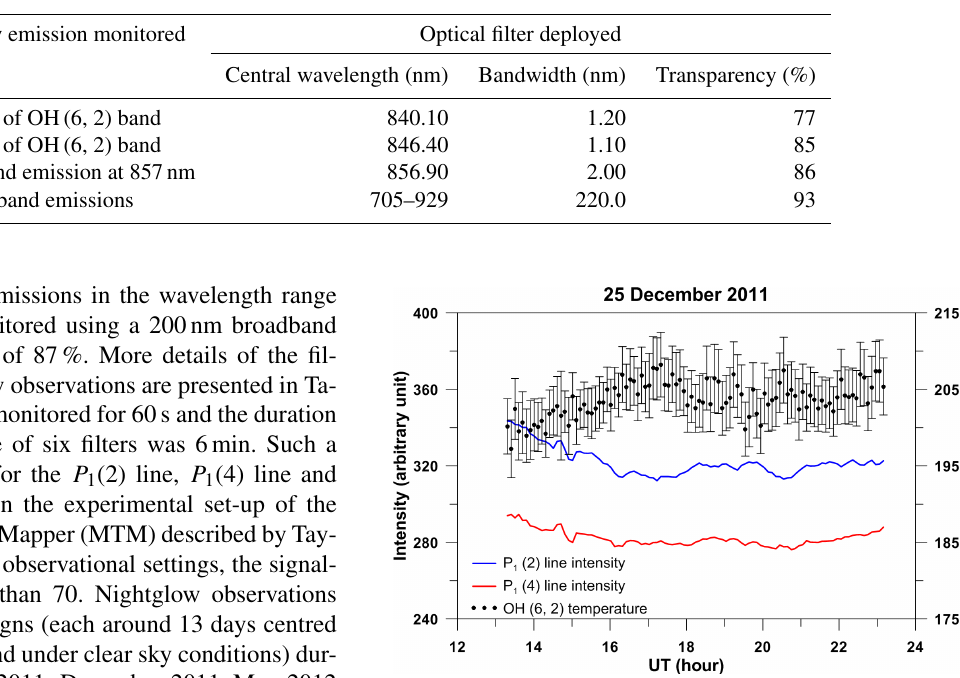
Figure 1. A typical example of the intensity series generated us- ing the image data and airglow temperatures over a geographic spot situated 1.5 ◦ latitude north of Ranchi (named NoRNC) on 25 De- cember